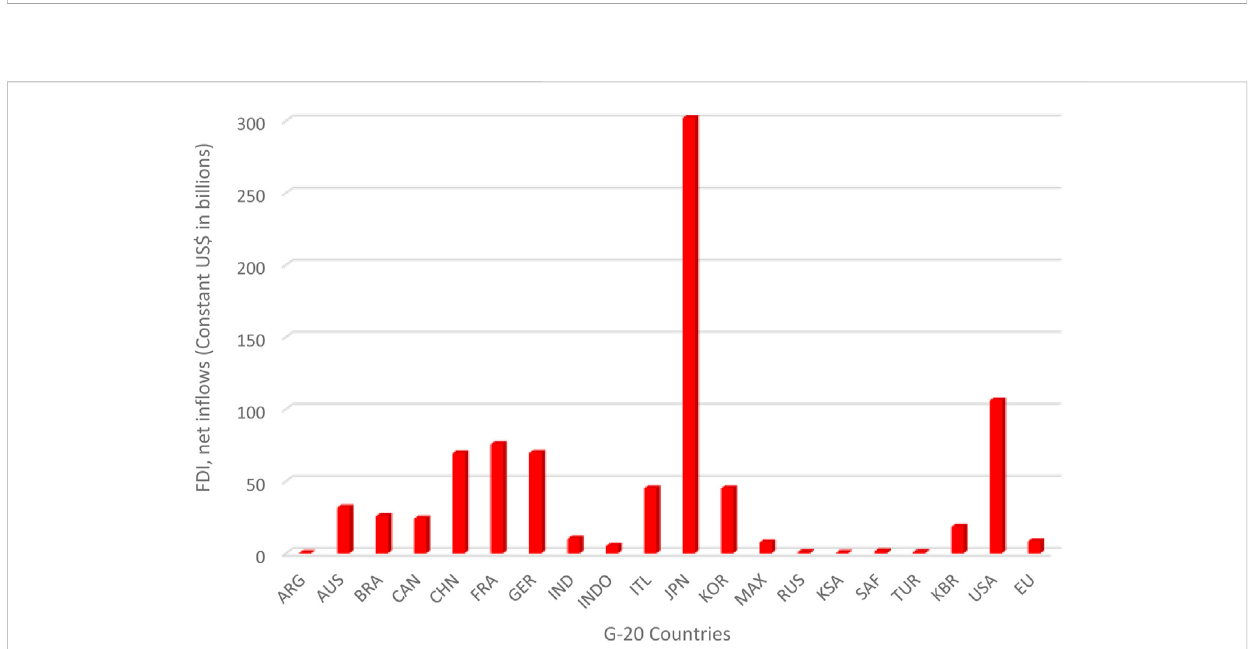
FIGURE 4 FDI, net in fl ows (Constant US$ in billions) of G-20 based on 2018. (Note: The data of FDI, net in fl ows ( Current US$ in billions) for each country were converted into constant values by dividing it from GDP de fl